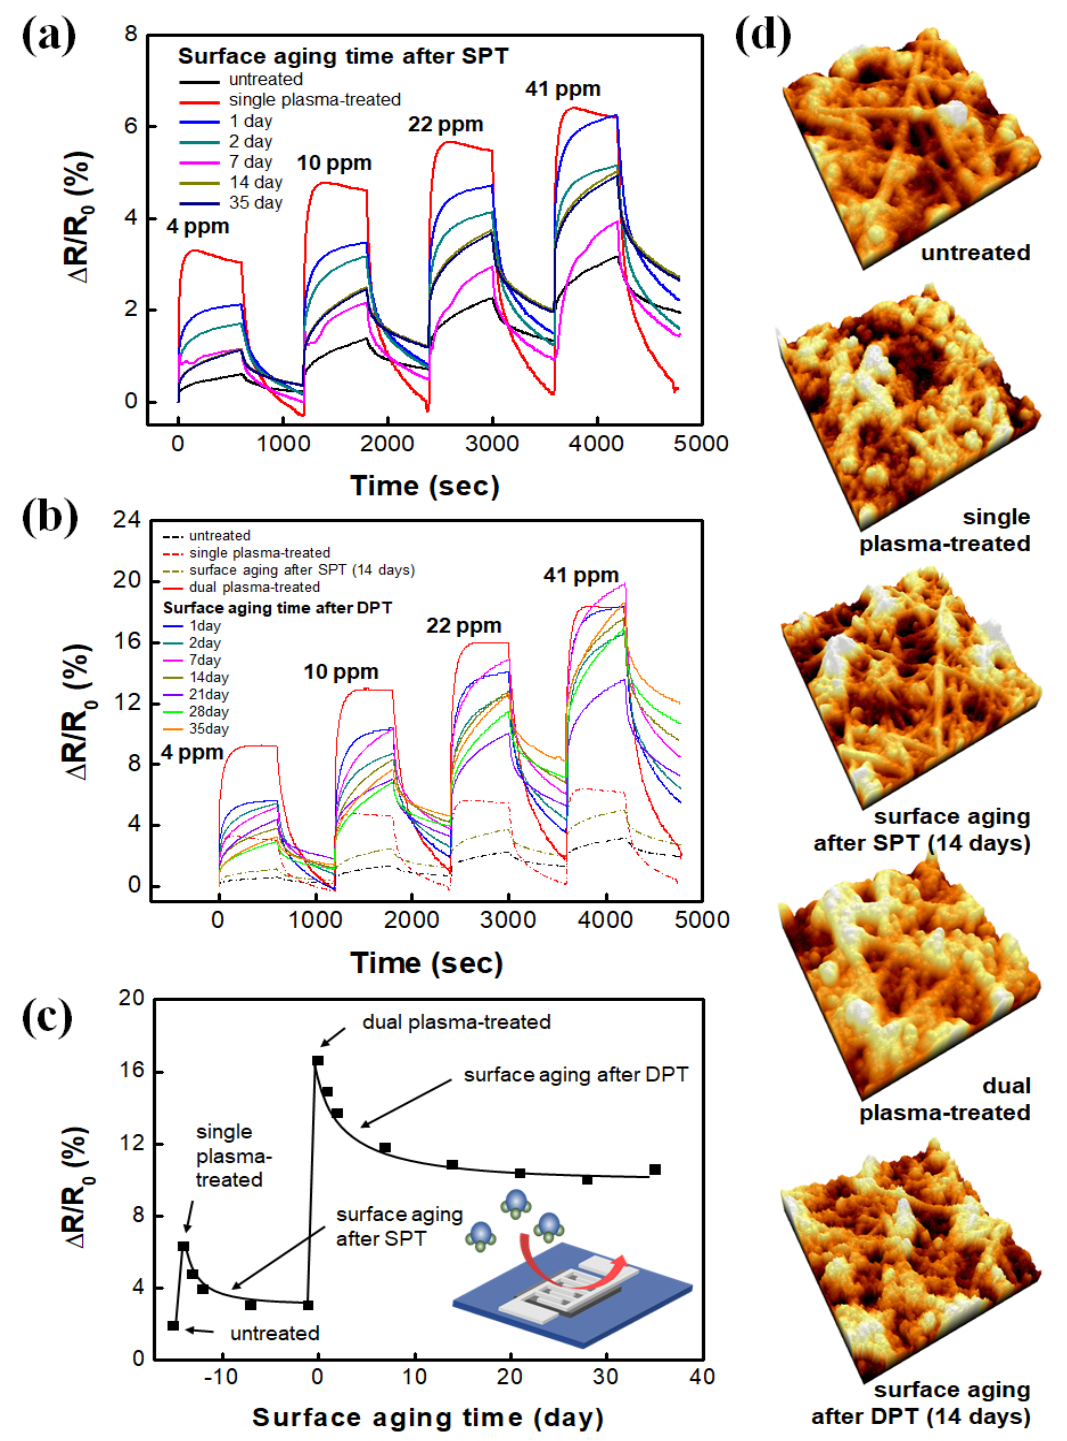
Figure 6. Dynamic responses to NH 3 gas of variously aged ( a ) SPT-SWCNT and ( b ) DPT-SWCNT electrodes; ( c ) aging curves derived from responses to 41-ppm NH 3 in ( a ) and ( b ) and ( d ) atomic force microscopy (AFM) surface images of the SWCNT films after each step of plasma treatment or 14-day- aging. Note that the variation in resistance to the NH 3 concentration that increased about 3.3 times due to the plasma treatment decreased to 25% after two weeks. Note that purified N 2 was used as a purging gas and to dilute the ammonia to the different experimental concentrations.